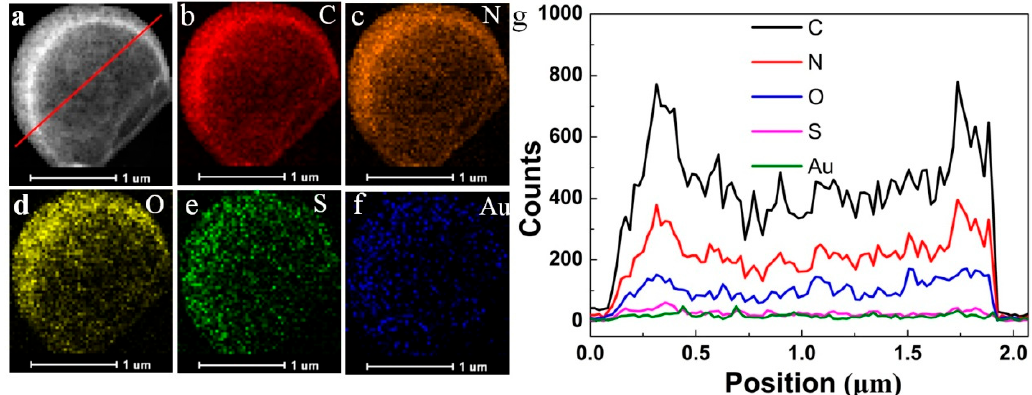
Figure 2. High-resolution transmission electron microscopy (HRTEM) showing continuous and robust HPs membrane ( a ). ( b – f ) The C, N, O, S, and Au elemental distribution. ( g ) EDS line profile analysis of C, N, O, S and Au elemental distribution in ( a ). Scale bars in ( a – f ) are 1 µm, respectively.